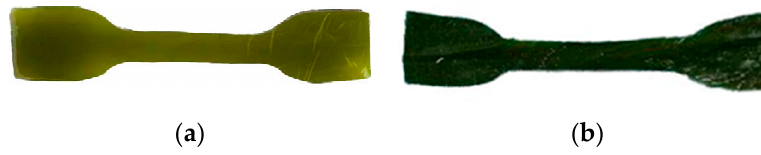
Figure 3. Dumbbell-shaped sample of wakame stem and leaf ( a ) Stem; ( b ) Leaf.